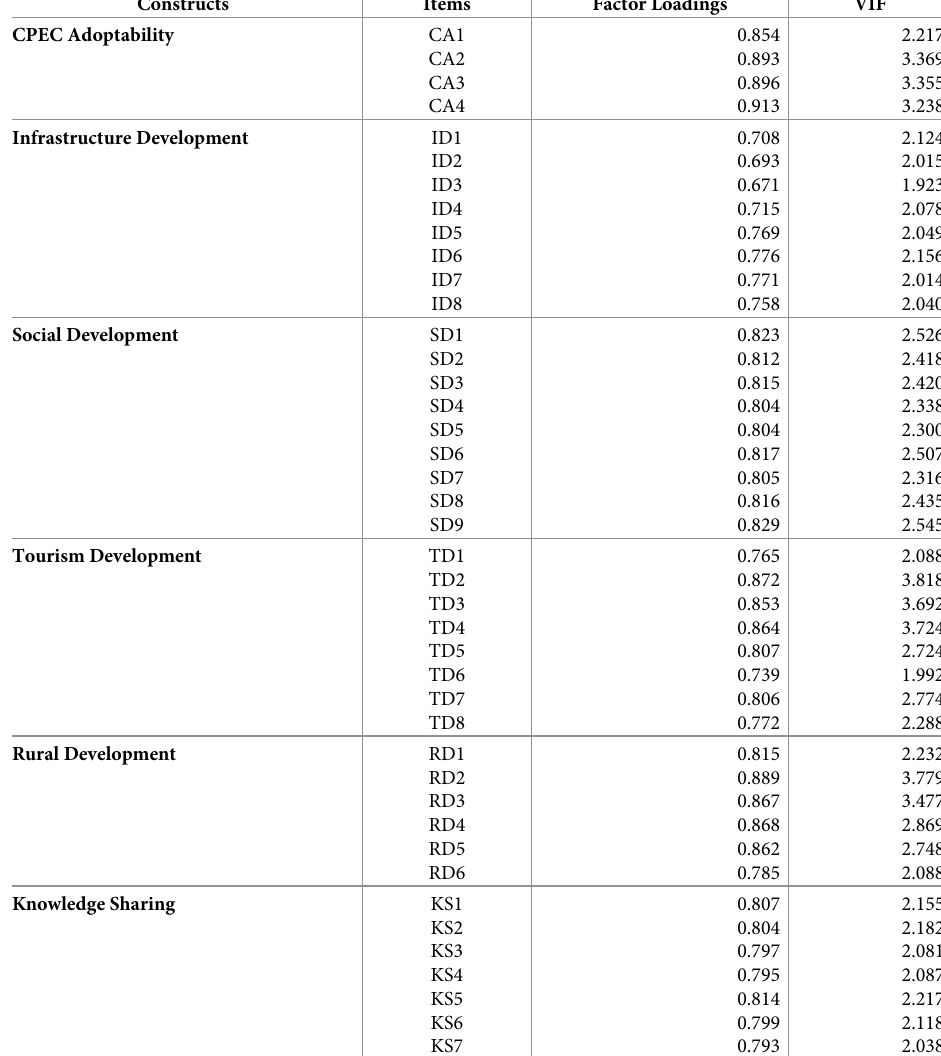
Table 5. Measurement of research model with factor loading and VIF